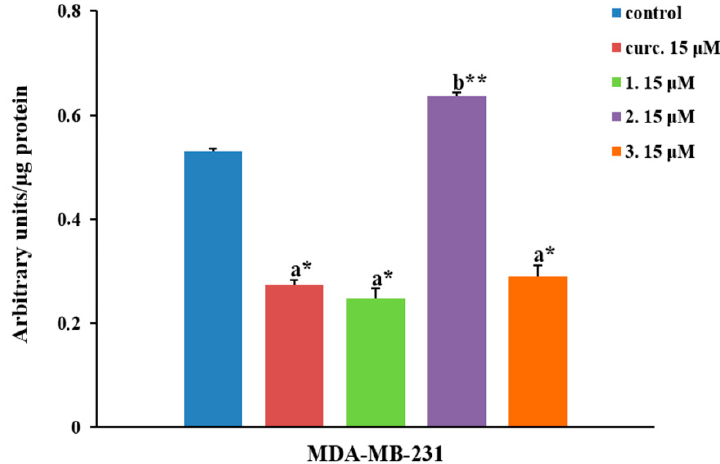
Figure 7. NF- κ B (p65 subunit) DNA binding capacity in nuclear extracts of MDA-MB-231 cells. The cells were treated for 8 h with curcumin and derivatives 1 – 3 . Results (mean ± standard error of two experiments carried out in duplicate) are expressed as arbitrary units / µ g protein of cells nuclear extracts. Di ff erent letters (a and b) in the column of the cell lines and treatments represent significant di ff erences among the di ff erent treatments. Di ff erences when treatments are compared to the control: ** p < 0.05, * p < 0.01.